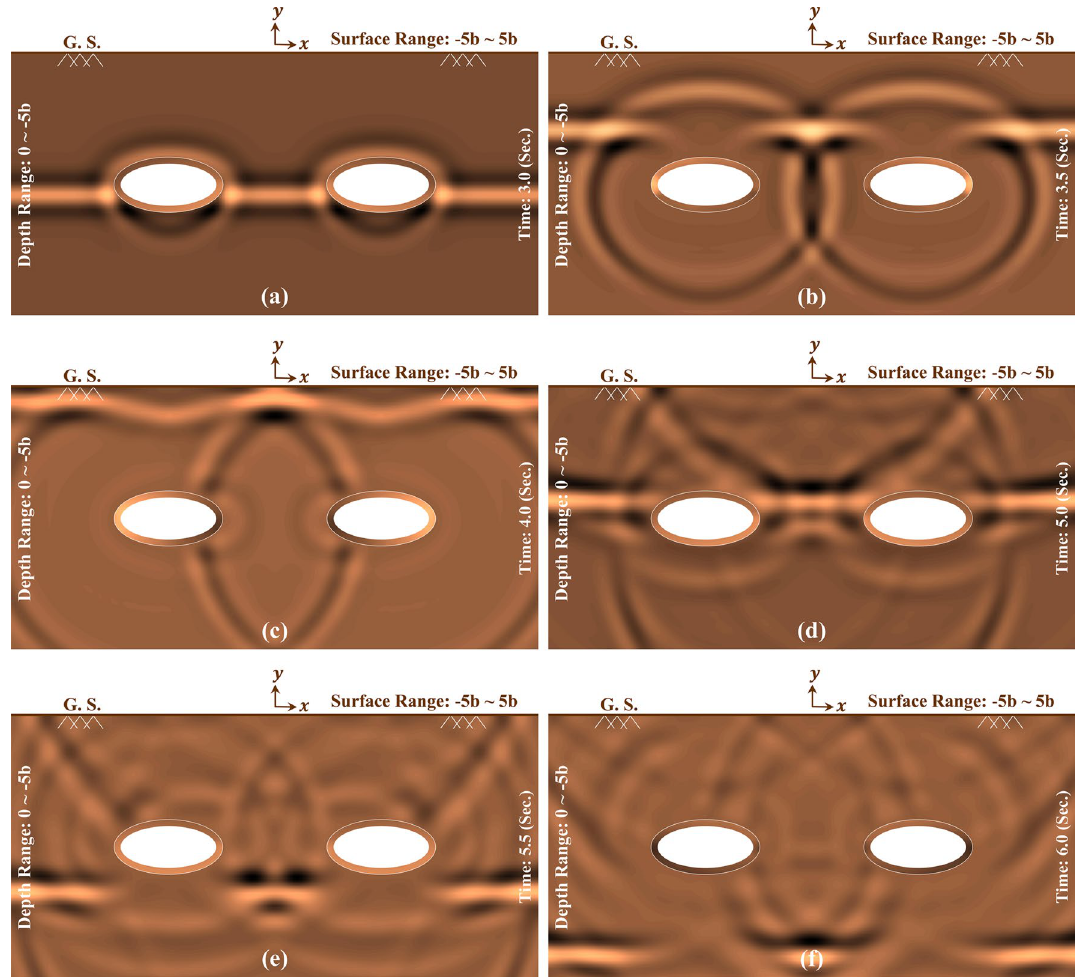
Fig. 6 Wave propagation snapshots and the procedure of the SH waves’ dispersion below the ground surface, for the model of twin ellipti- cal-shaped lined tunnels subjected to vertical incident